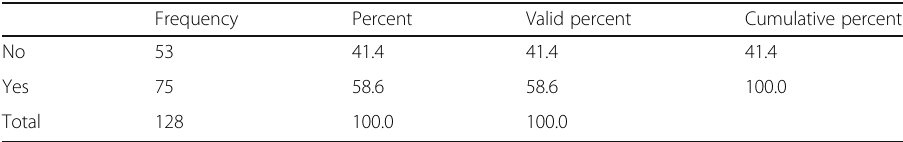
Table 14 Livelihood